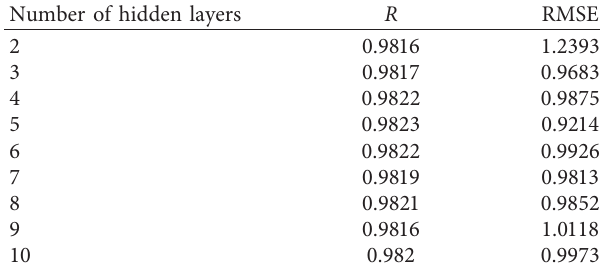
Table 5: Selection of best architecture for